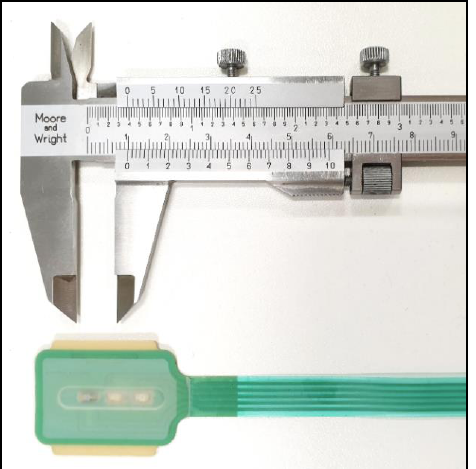
Figure 1. The endotracheal photoplethysmography (PPG) sensor before installation onto the Figure endotracheal (ET) tube.